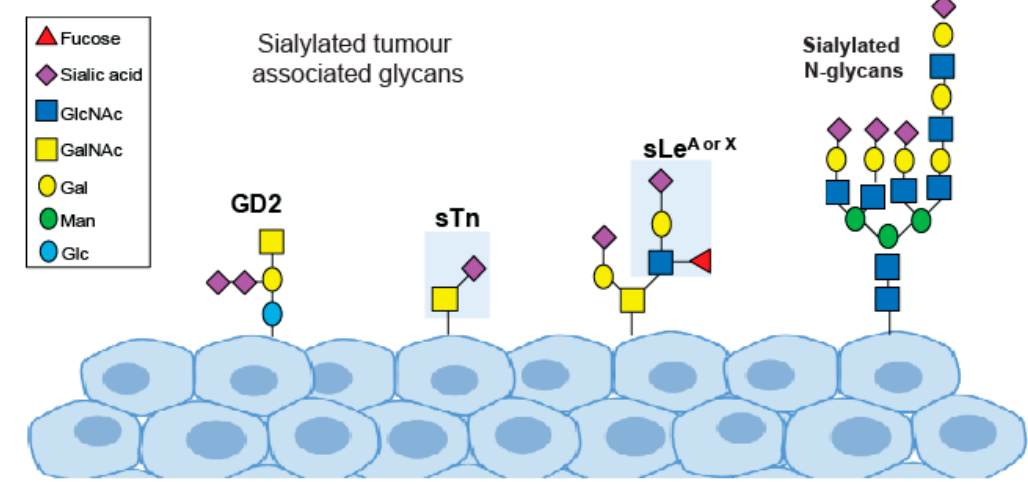
Figure 1. Sialylated glycans important in cancer.